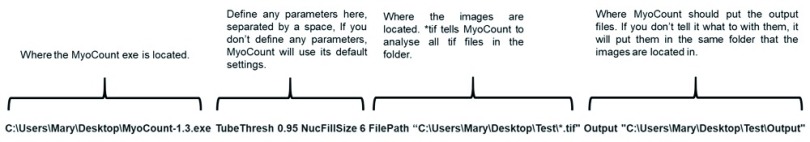
MyoCount command prompt syntax.